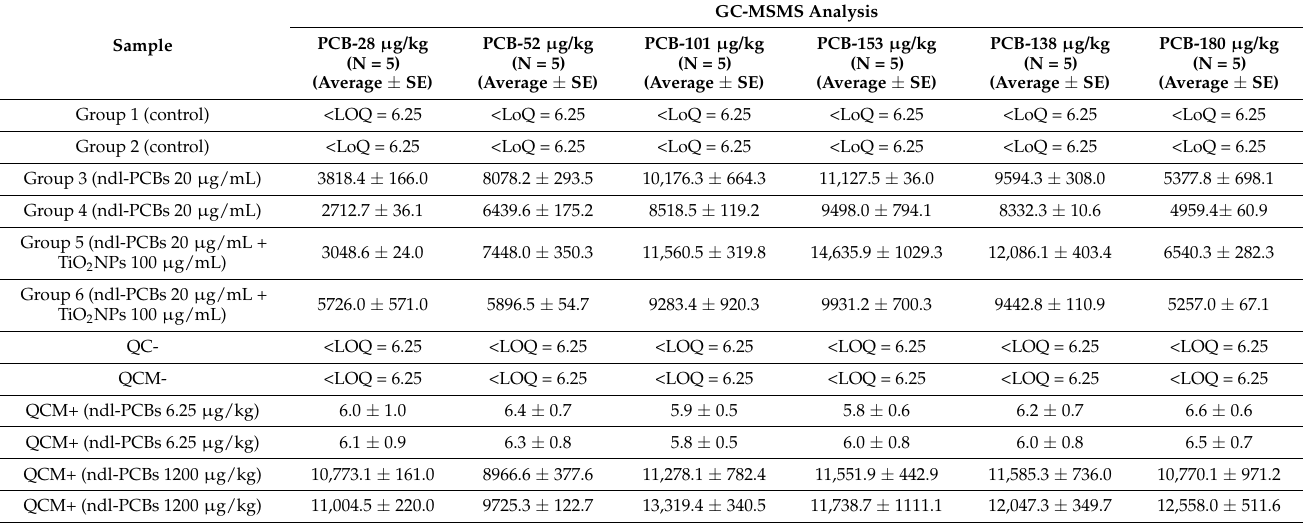
PCBs and TiO 2 NPs).